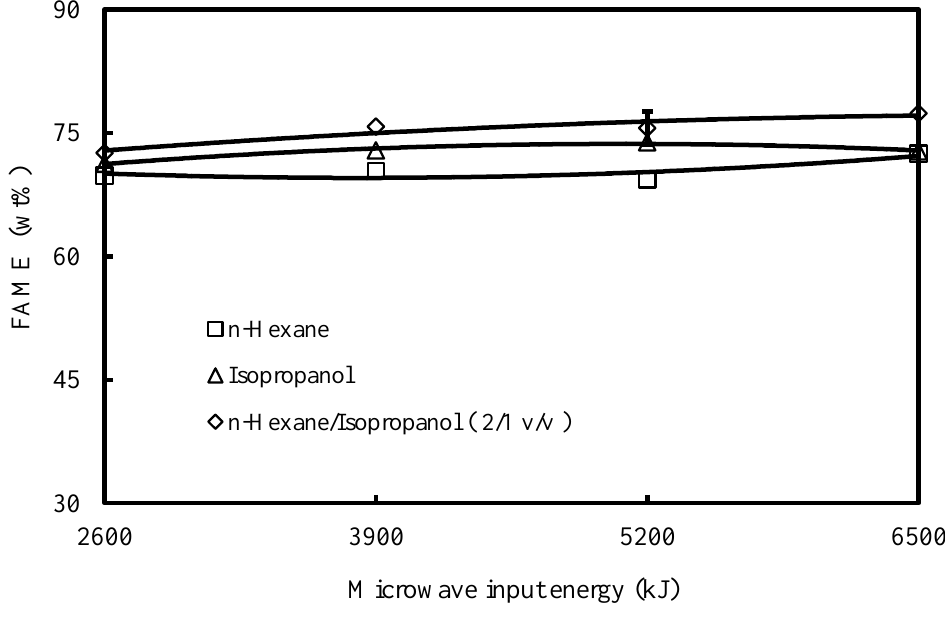
Figure 7. Comparison of the quantities of fatty acid methyl esters (FAME) extracted from the microalgae lipids using the microwave-assisted extraction method with various